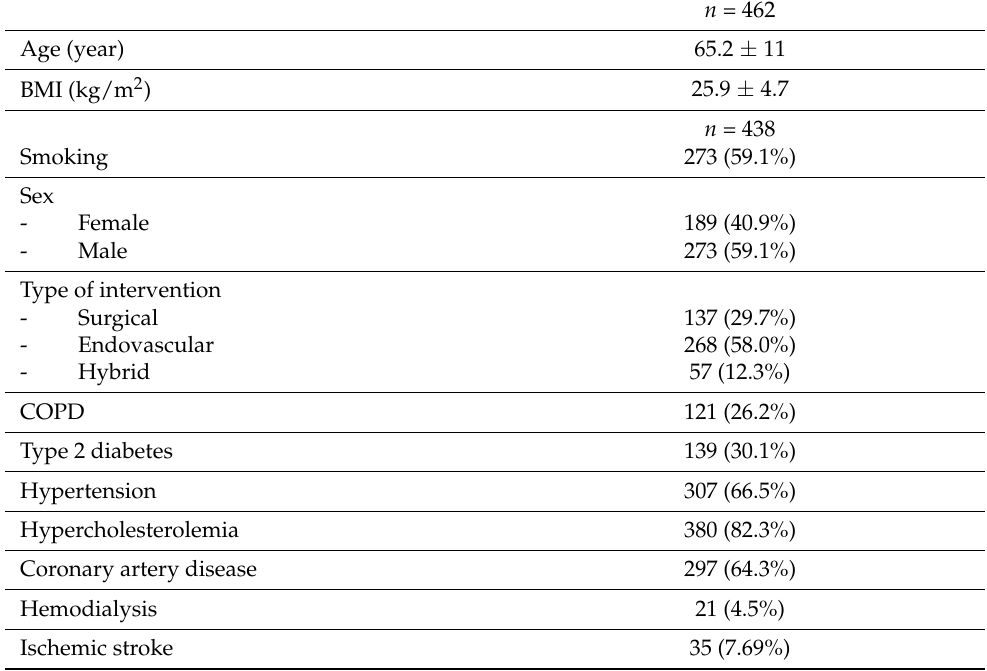
Table 1. Patient